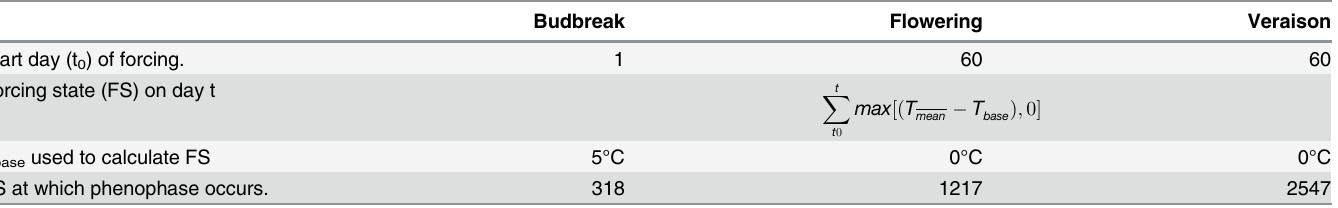
Table 1. Parameters & forcing equation for spring warming models [58, 60, 62] used to simulate the timing of budbreak, flowering and veraison. The same forcing equation, using different starting times and base temperatures and where T mean is the mean temperature of day t , applies to all three phenophases.